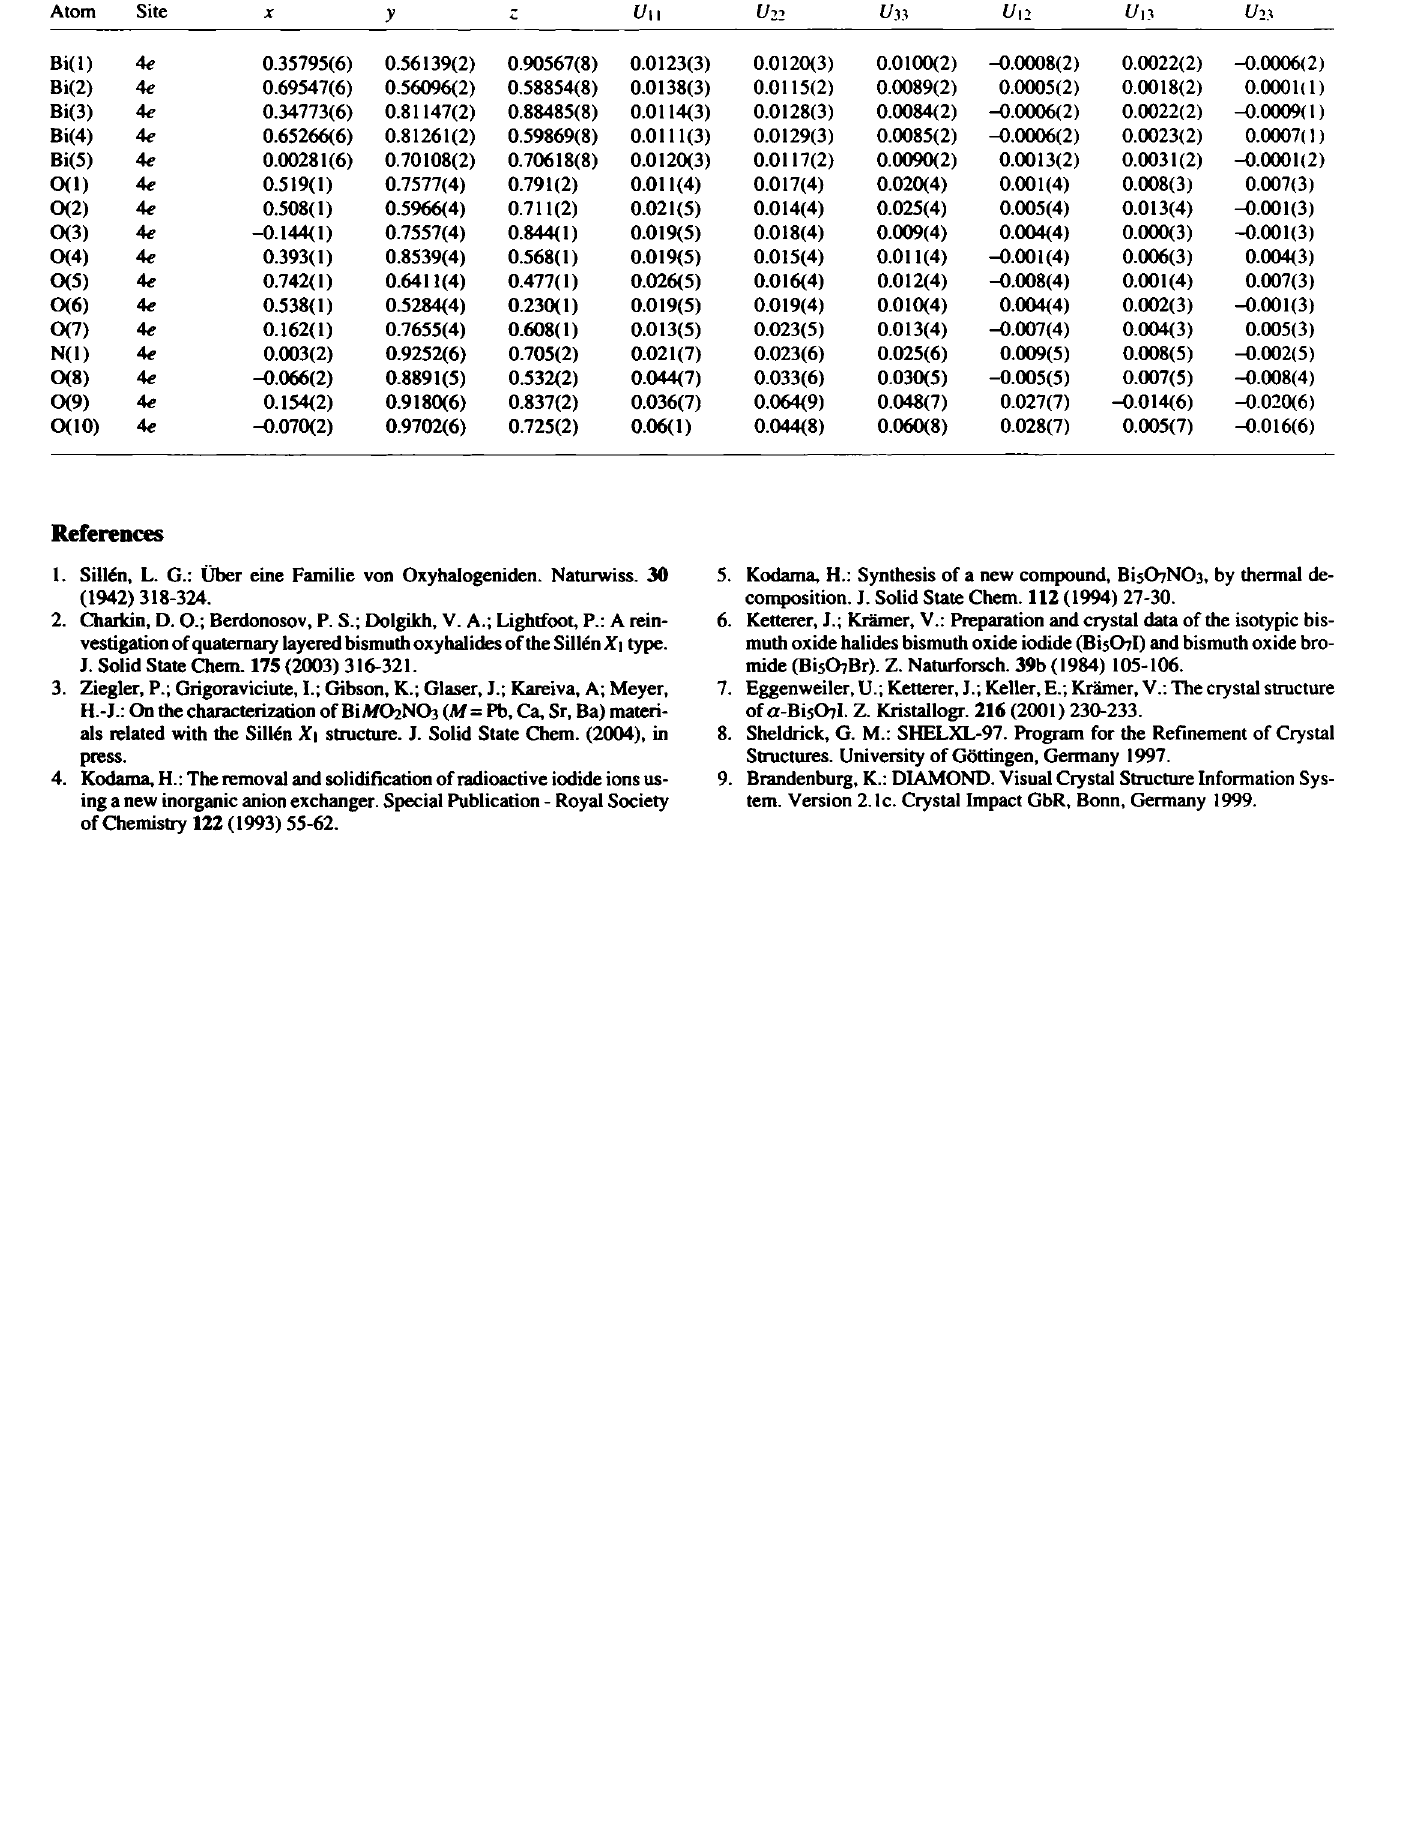
Table 2. Atomic coordinates and displacement parameters (in Â 2